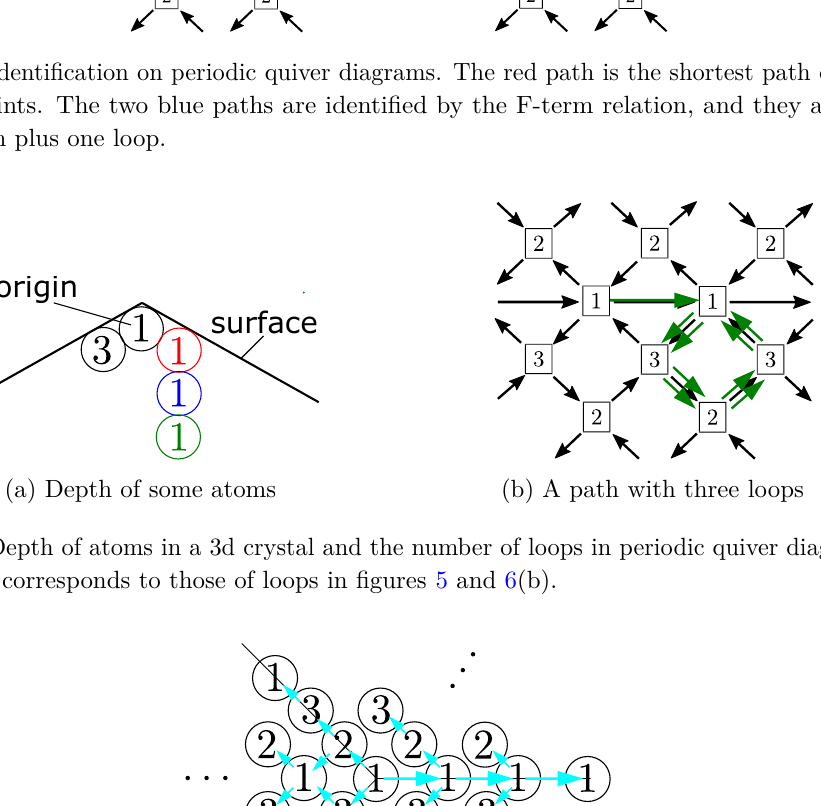
Figure 7. The surface of the 3d crystal for gl and we can see they are different from the plane